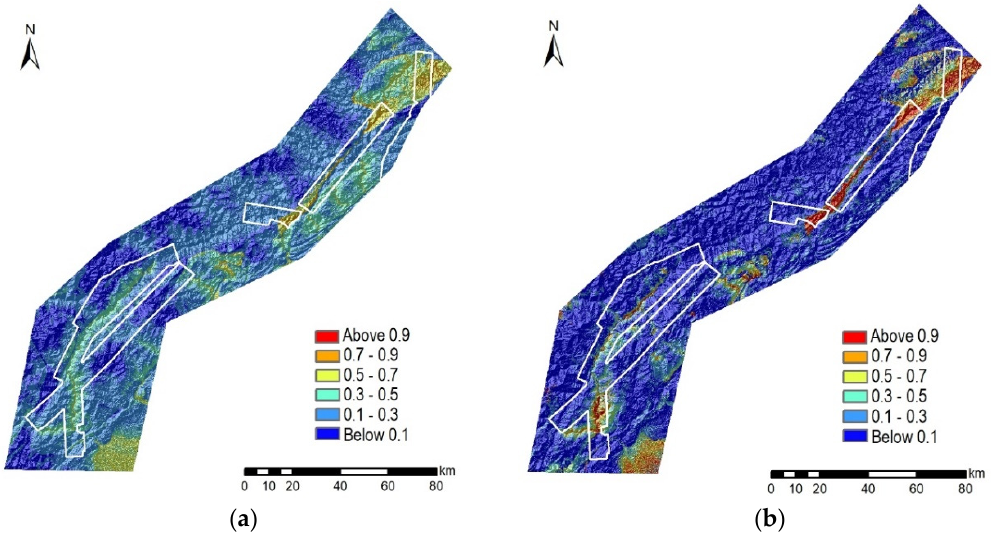
Figure 15. ( a ) Application of the LR model to predict the landslide susceptibility of the whole study area; ( b ) Application of the support vector machine (SVM) model to predict the landslide susceptibility of the whole study area. The white polygons show the areas covered by the airborne imagery.